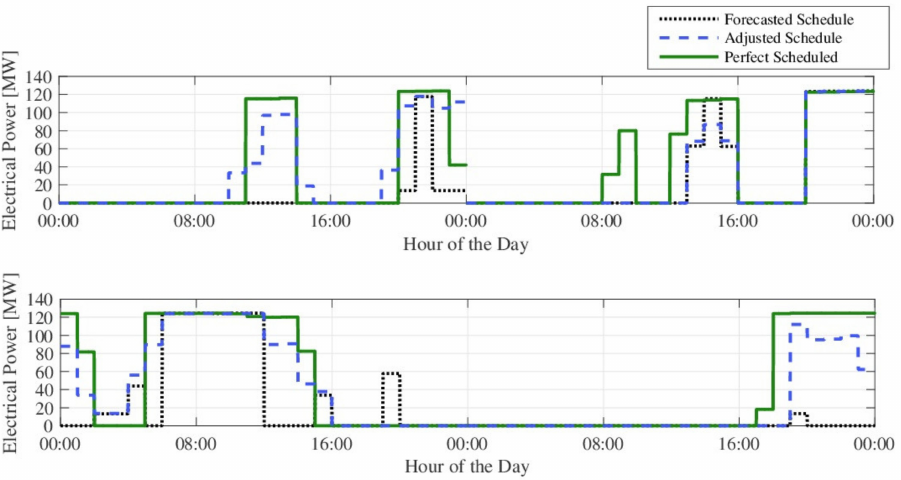
Figure 9. Forecasted, adjusted and perfect schedule for some example